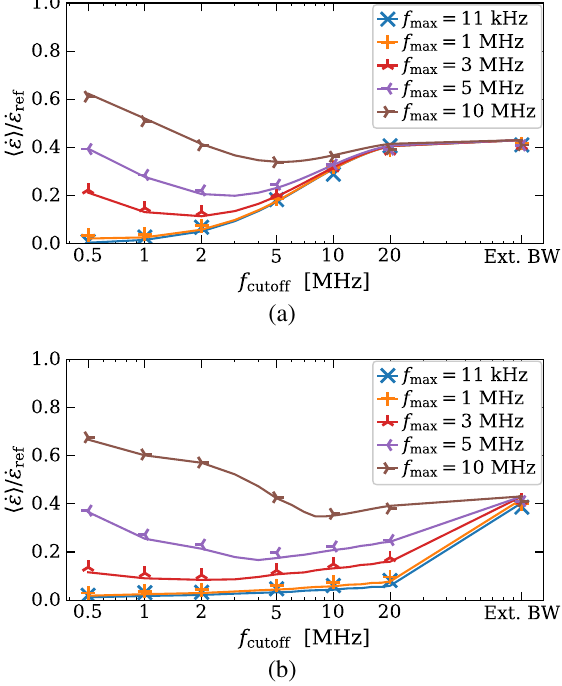
FIG. 4. Average emittance growth for 128 neighboring bunches affected by LF noise of various f , using the EXP filter in (a) max and the ADT filter in (b). The solid lines are the expected emittance growth rates, calculated with Eqs. (11) and